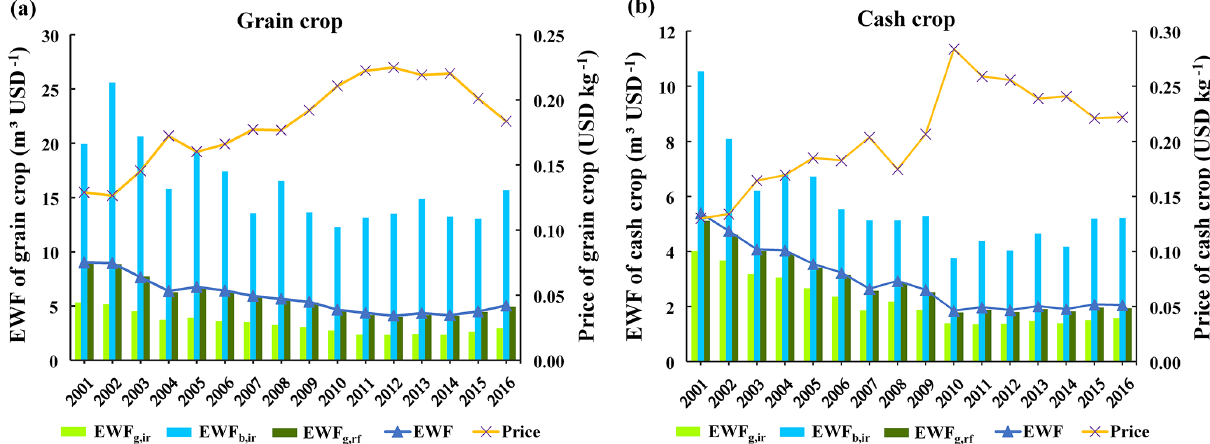
Figure 5. Interannual variability of economic value-based water footprint (EWF) of (a) grain and (b) cash crops in China over